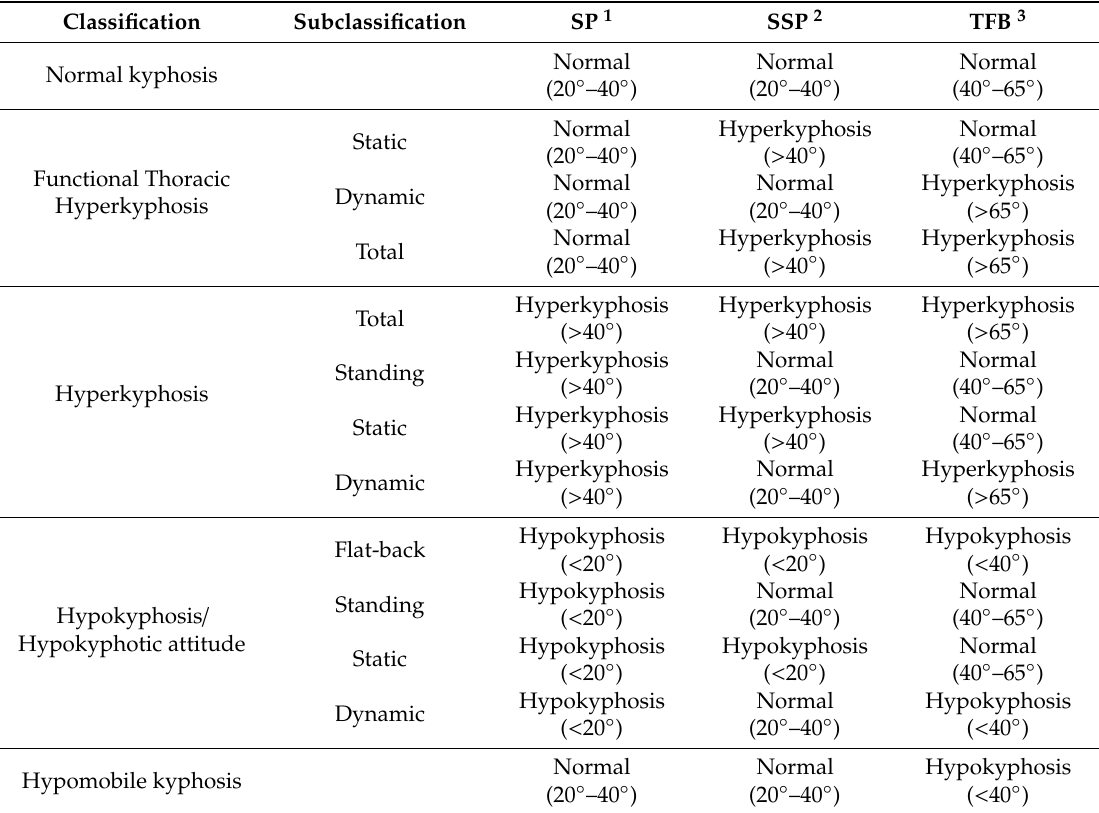
Table 2. Diagnostic classification of the “Sagittal Integral Morphotype” for the thoracic curve.